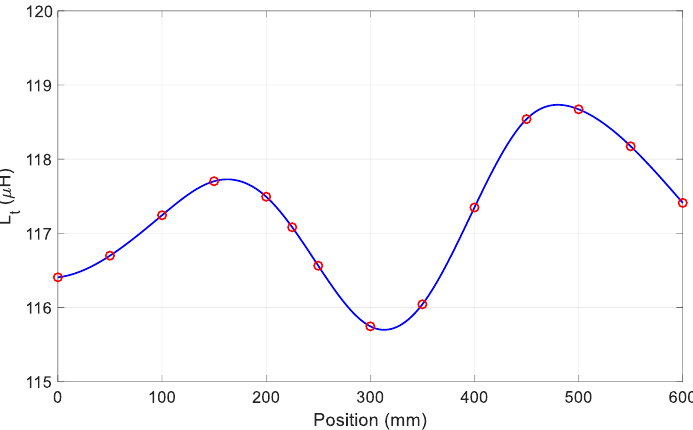
Figure 7. Self-inductance of the transmitting coil at different coil positions.